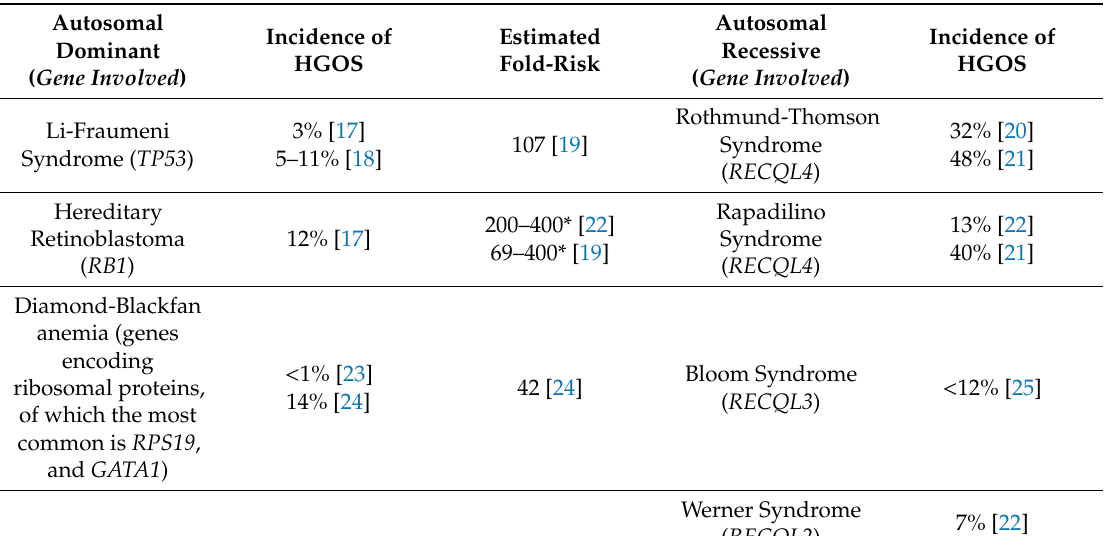
Table 1. Rare cancer predisposition syndromes associated with